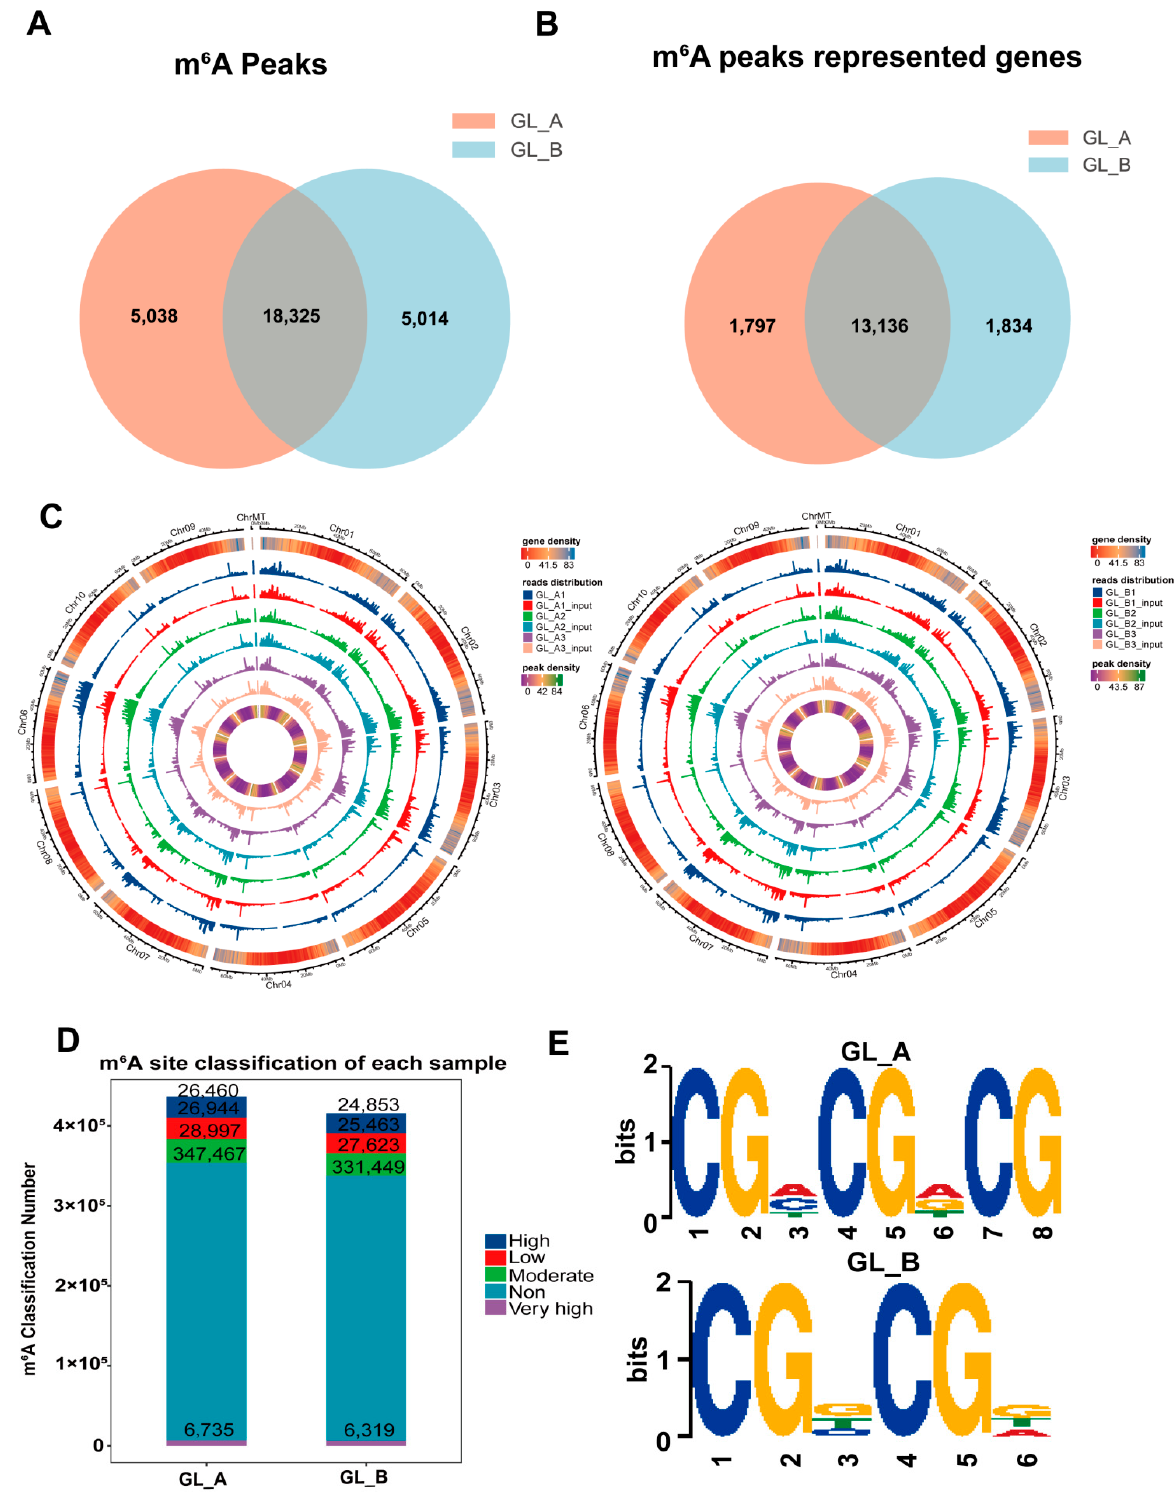
Figure 6. Transcriptome-wide m 6 A analysis in sorghum under GA 3 treatment. ( A ) The quantity of common and distinct m 6 A peaks following GA 3 (GL_A) versus control (GL_B) treatment. ( B ) A Venn diagram illustrating the m 6 A-associated mRNAs in both leaves. ( C ) m 6 A peak distribution across chromosomes in both leaves. ( D ) m 6 A site stratification in both leaves. ( E ) The top motif enrichments are related to m 6 A peaks in both